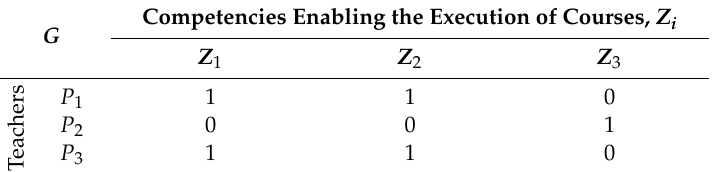
Table 1. Competency framework, G .